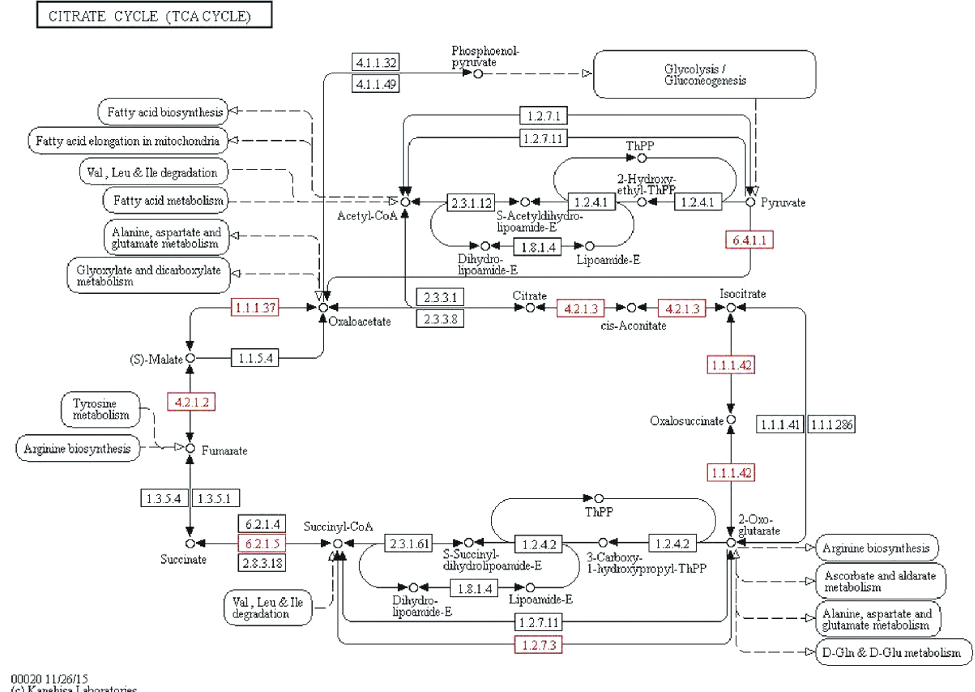
Figure 2: Pictorial representation of reductive citric acid cycle for autotrophic CO tions are shown by arrows. Enzyme activities: 1, malate dehydrogenase (EC 1.1.1.37); 2, fumarate hydratase (fumarase) (EC 4.2.1.2); 3, fumarate reductase; 4, succinyl-CoA synthetase (EC 6.2.1.5); 5, 2-oxoglutarate:ferredoxin oxidoreductase (EC 1.2.7.3); 6, isocitrate dehydrogenase (EC 1.1.1.42); 7, aconitate hydratase (aconitase) (EC 4.2.1.3); 8, ATP citrate lyase (EC 2.3.3.8); and 9, pyruvate: ferredoxin oxidoreductase (EC 1.2.7.1). Fd the genome of tuberculosis strains were highlighted with red